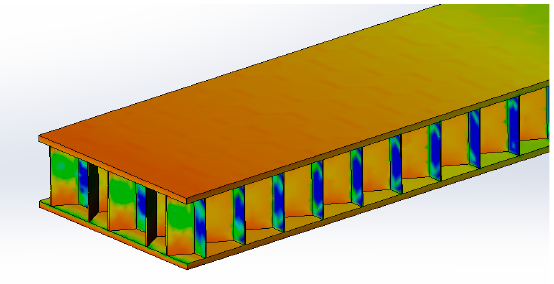
Figure 5. Graphical example of the design stress in a honeycomb structure during bending.